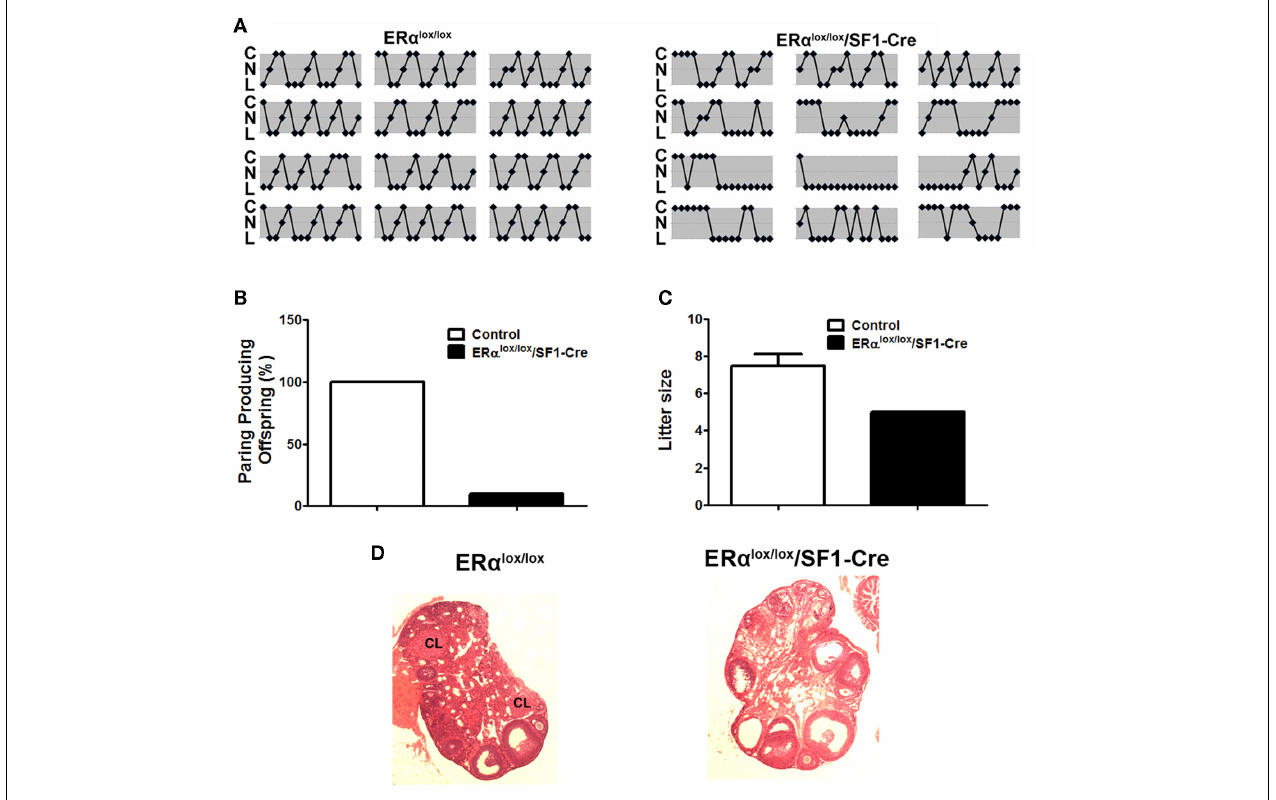
neurons and their wild-type controls were paired with genetically normal control males and the numbers of pairings producing pups were quantified. (C) . Litter size from dams that successfully delivered pups in (B) . (D) H&E staining of ovaries from adult female mice.There was no corpus luteum in the ovary from mice lacking ER α in SF1